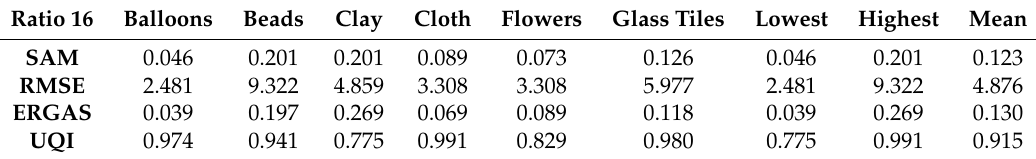
Table 4. Spectral quality indexes for the higher spatial resolution CAVE images trained with input of 32 × 32 pixels.